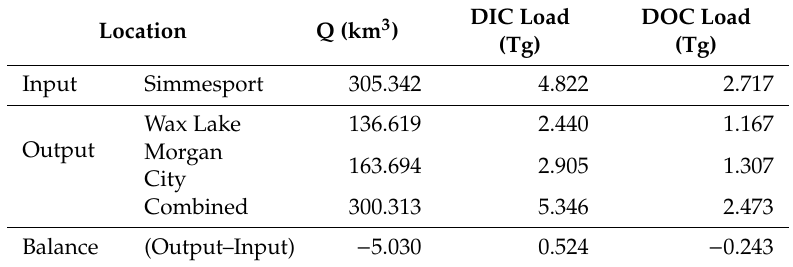
Table 3. Summary of discharge (Q), DIC, and DOC mass flux and balance for the entire sampling period from 1 May 2015 to 31 May 2016. Negative values indicate loss from origin to